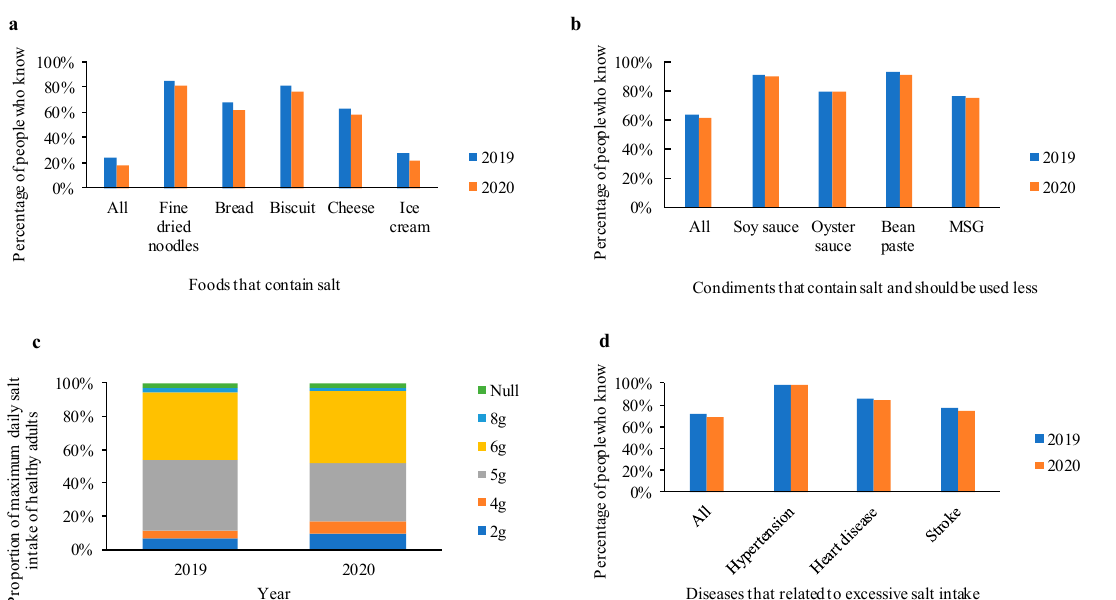
Figure 1. Comparison of salt-related knowledge status between 2019 and 2020. ( a ) Foods that contain salt; ( b ) condiments that contain salt and should be used less; ( c ) maximum daily salt intake of healthy adults; ( d ) diseases that related to excessive salt intake.